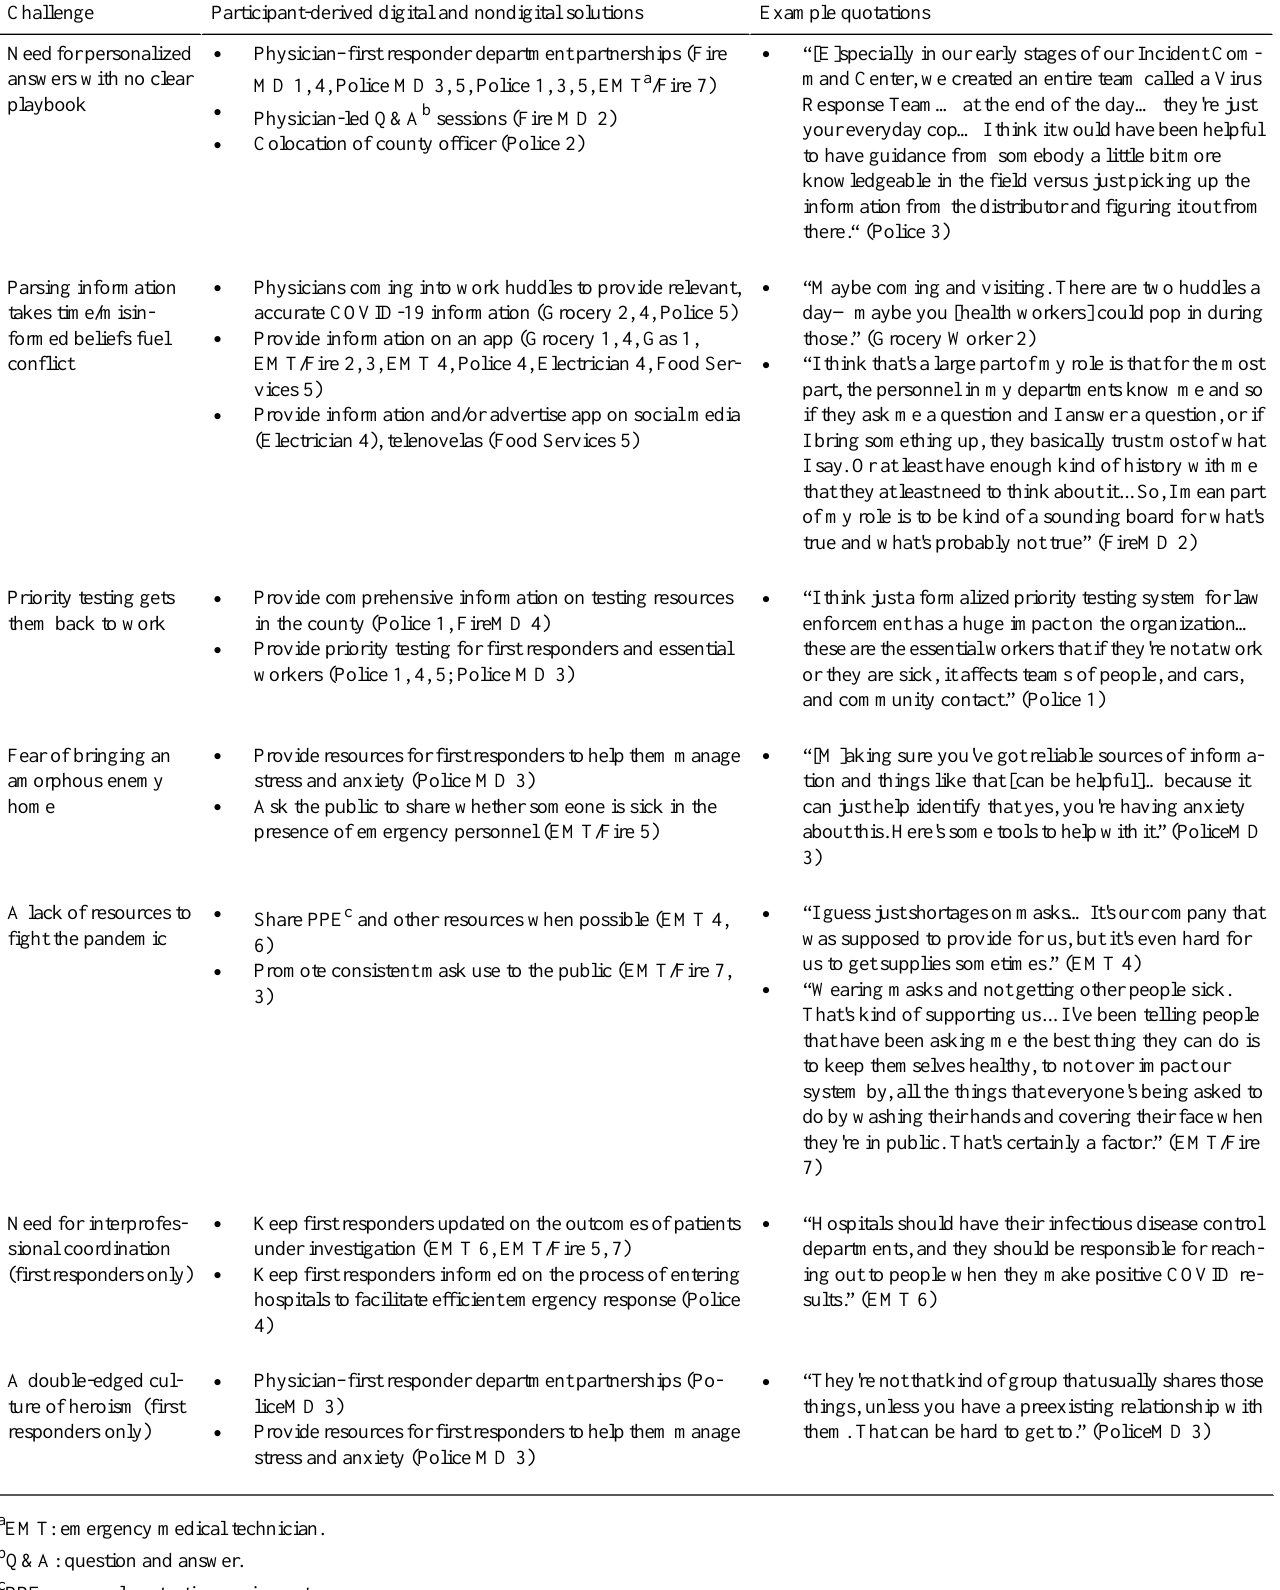
Table 3. Participant-derived digital and nondigital solutions to support first responders and essential workers during a